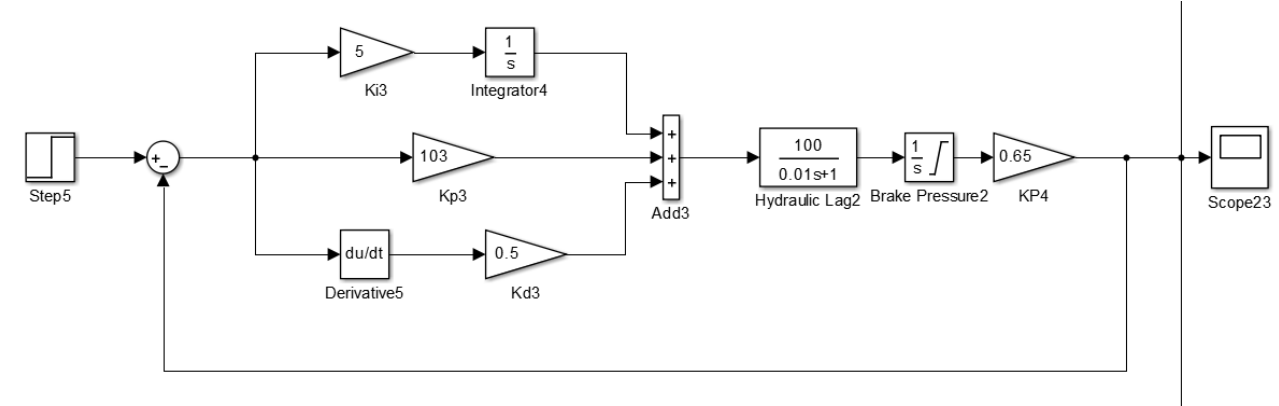
Figure 9. PID controller in Simulink.